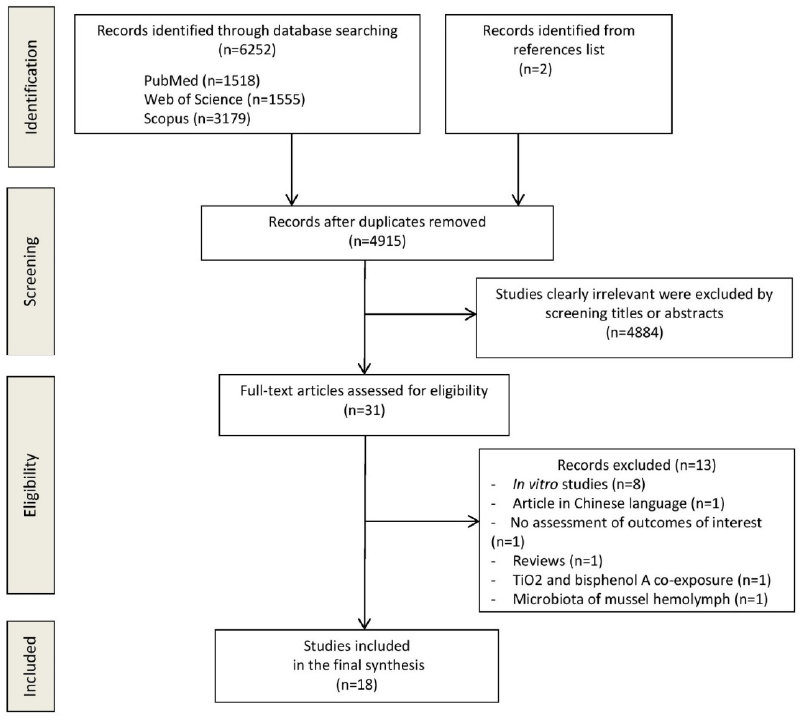
Figure 1. Preferred reporting items for systematic reviews and meta-analyses (PRISMA) flow